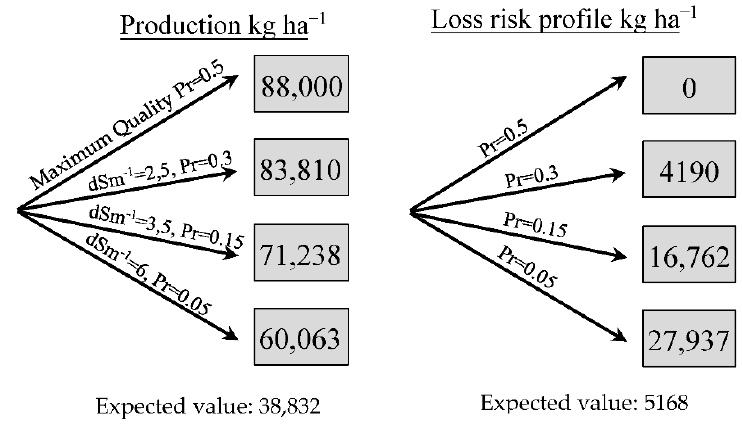
Figure 5. Decision tree of loss due to salinity in kg ha − 1 .